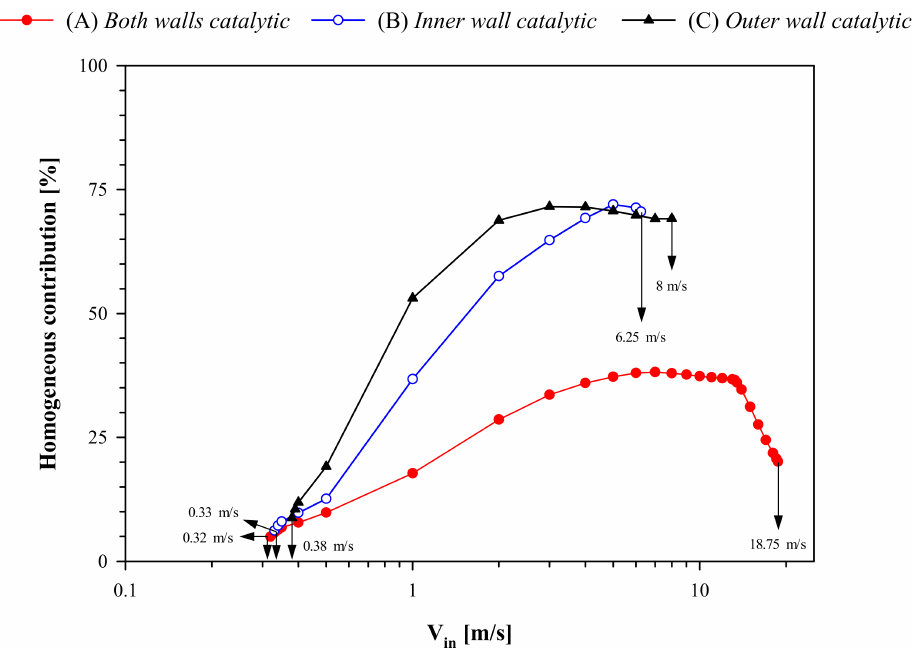
Figure 10. Homogeneous contribution to the conversion of propane (Equation (1)) as a function of V in for the three reactor configurations of Figure 1 with different catalyst placement. High thermal conductivity (30 W/(m K)). Arrows indicate extinction (at low values of V in ) and blowout (at high values of V in